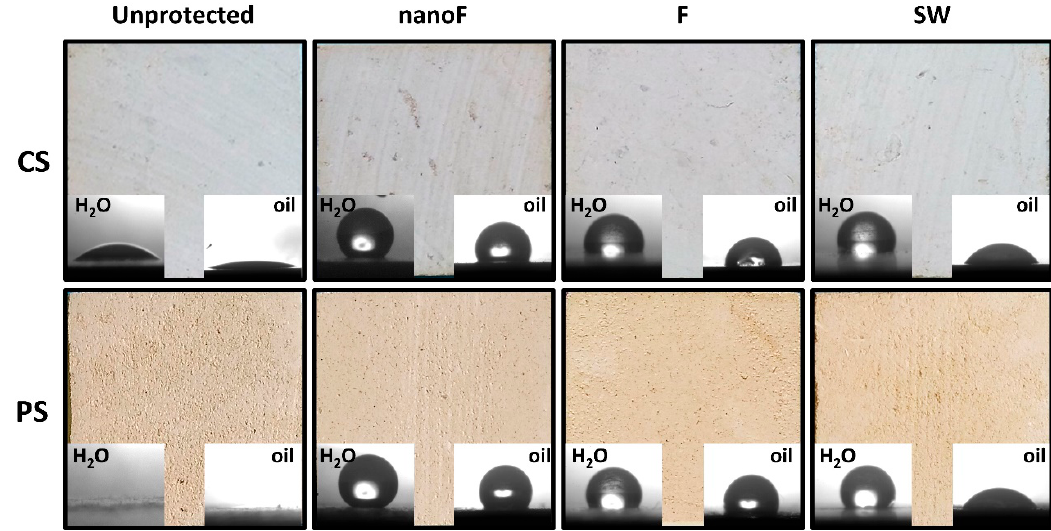
Figure 6. Water and oil droplets on the stone surfaces before and after the protective treatments.